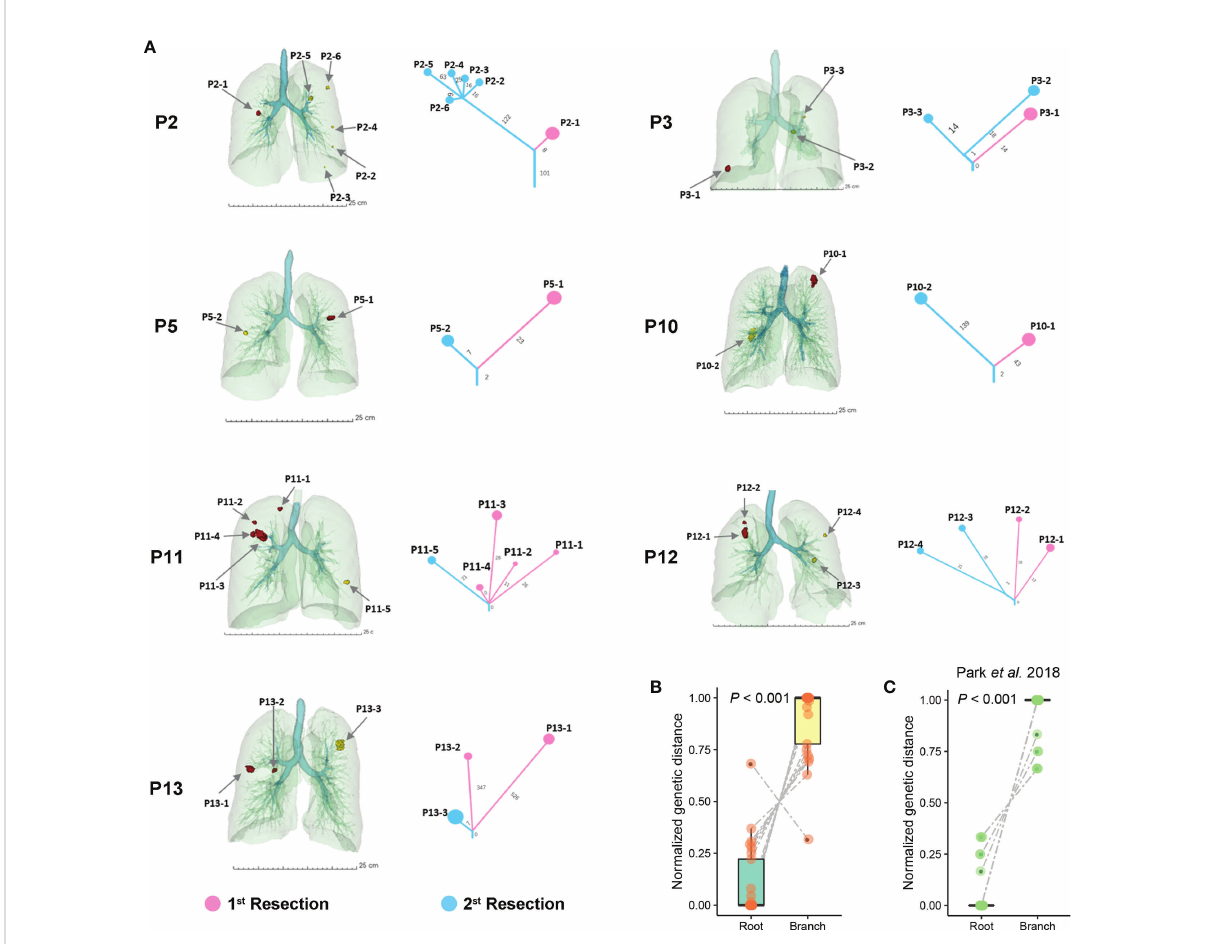
FIGURE 2 Phylogenetic trees of patients with sMPLC. (A) 3D locations of GGOs for patients with sMPLC. All analyzed lesions were shown before and after the use of Sintilimab. The phylogenetic relationship of multiple GGOs was demonstrated for per case. (B) The comparison of genetic distance between roots and branches among all included seven patients. (C) Phylogenetic analysis on another independent dataset of sMPLC, and the comparison between rooted and branched distance was also conducted (See